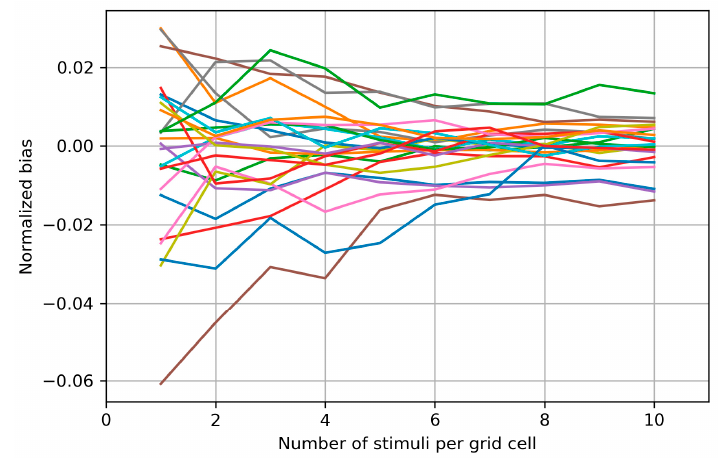
Figure A3. Bias of the area of the cells with more than half suprathreshold MEPs for all sessions of all subjects.